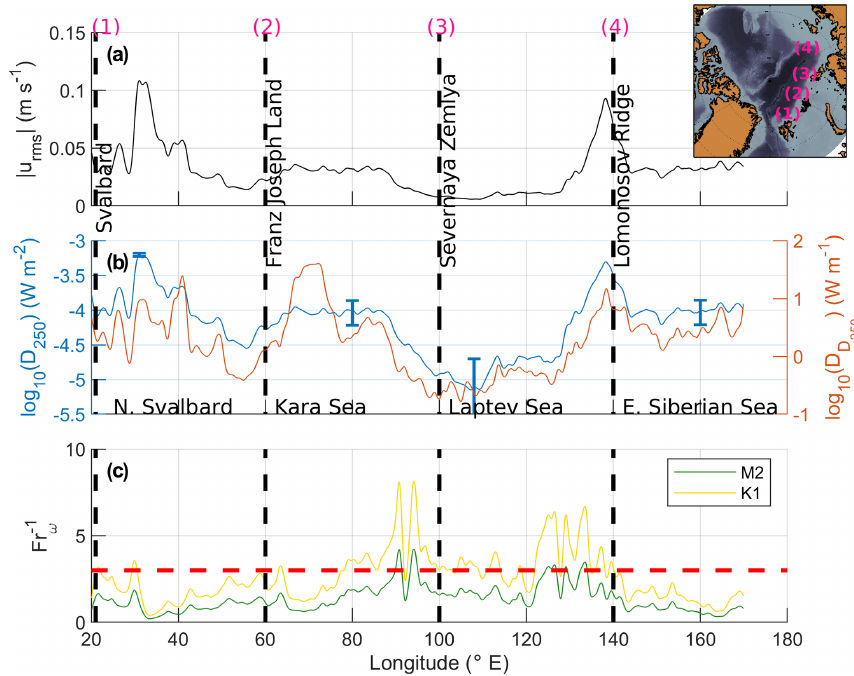
Figure 10. (a) Typical cross-isobath tidal speed along the Eurasian continental slope obtained from Arc5km2018 and averaged meridionally between the 400 and 1200m isobaths. (b) Left axis: the depth-integrated dissipation rate in the bottom 250m, D 250 , calculated from the tidally driven bottom drag using the relation in Fig. 8b, averaged between the 400 and 1200m isobaths. The blue vertical bars, shown at selected locations for clarity, are the error bars from the uncertainty on the equation in Fig. 8b. Right axis: D 250 integrated laterally between the 400 and 1200m isobaths. (c) Inverse Froude number for both the semidiurnal M 2 (green) and the diurnal K 1 tidal components (yellow). The red dashed line is Fr − 1 ω = 3, a threshold for the development of nonlinear processes (Legg and Klymak,